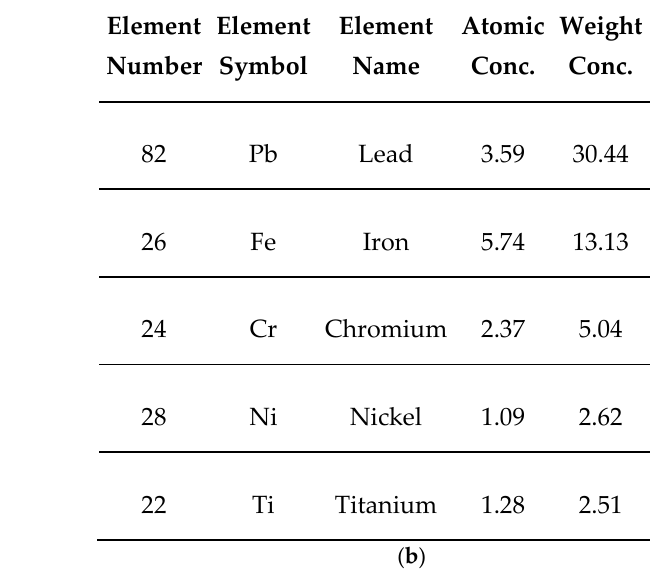
termined by SEM ‐ EDS (FOV: 86.6 μ m, Mode: 15 kV—Image, Detector: SED).